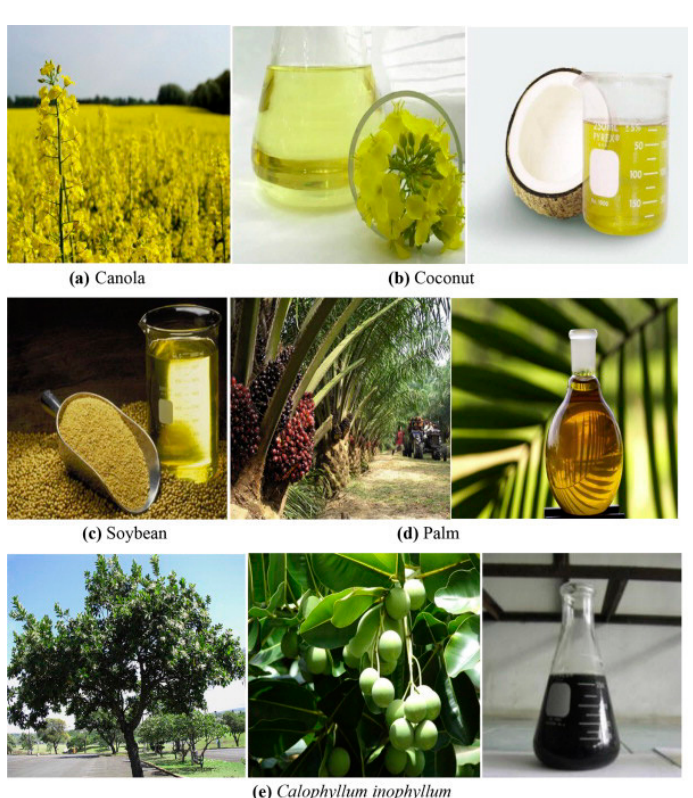
Figure 7. Edible feedstock for biodiesel production [118]. Table 4. Properties of first ‐ generation biodiesel [12,118–121].